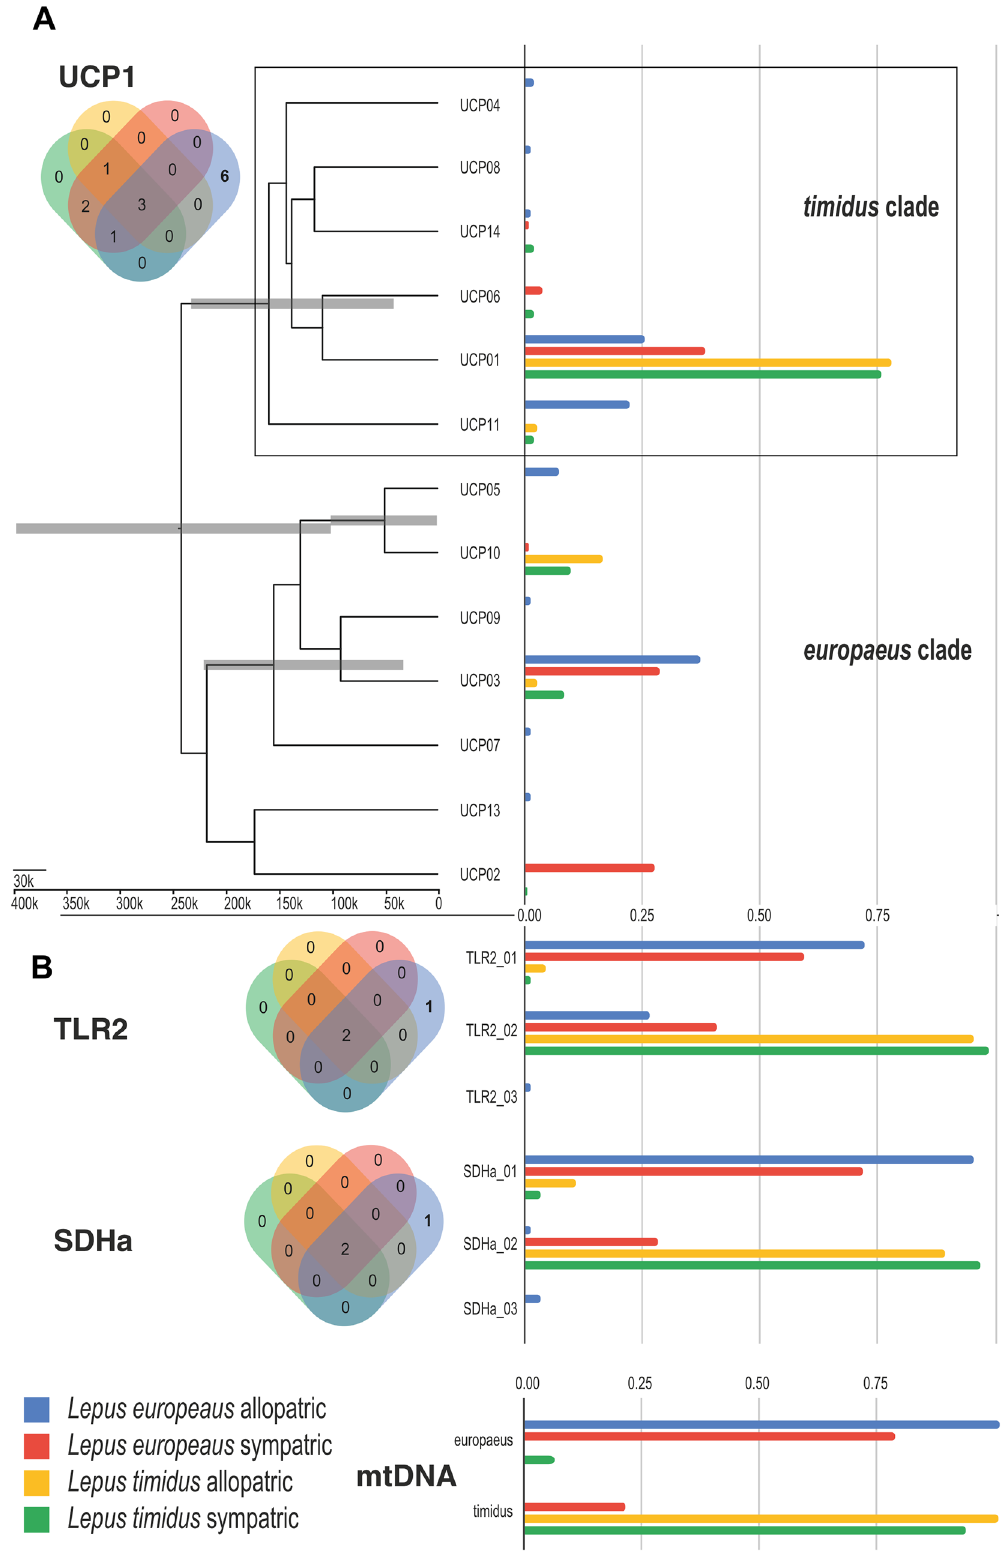
Figure 2. Ultrametric tree of UCP1 and allele frequency bar chart of TLR2 and SHDa allele frequencies and mtDNA haplotypes ( timidus or europaeus ) in hare populations. The bars over the tree nodes represent the 95% confidence interval of the node height. The colors of the allele frequency bar chart represent each of the populations tested. Venn diagrams depict the numbers of unique and shared alleles for each population (same coloring as for the allele frequency bar chart). Private allele numbers in